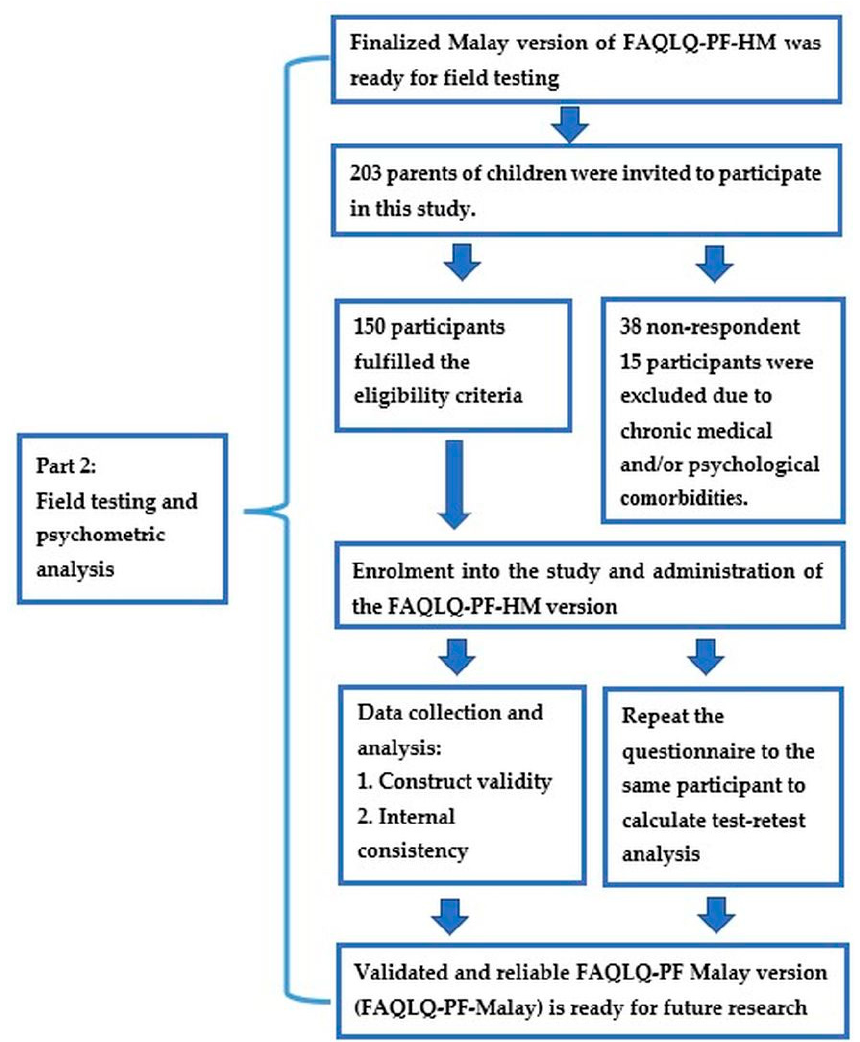
Figure 2. Part 2 study conduct flow chart. FAQLQ-PF-HM: Food Allergy Quality of Life-Parent Form-Harmonized Malay